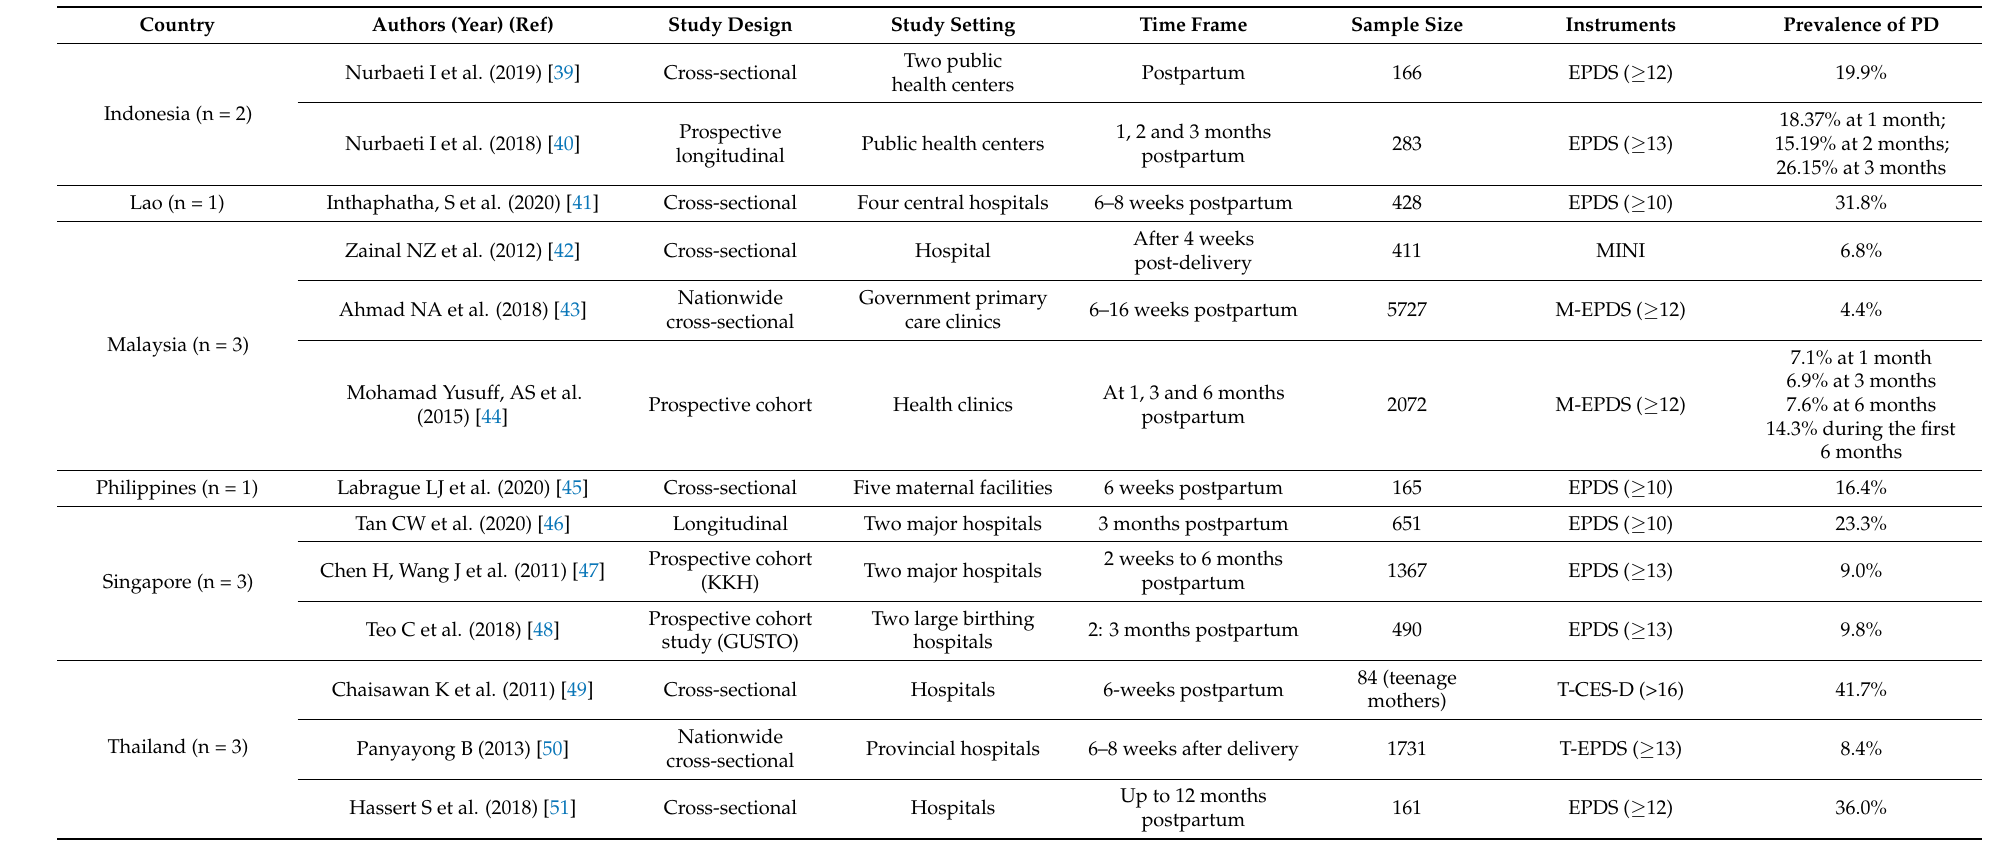
Table 5. Prevalence of postnatal depression and their